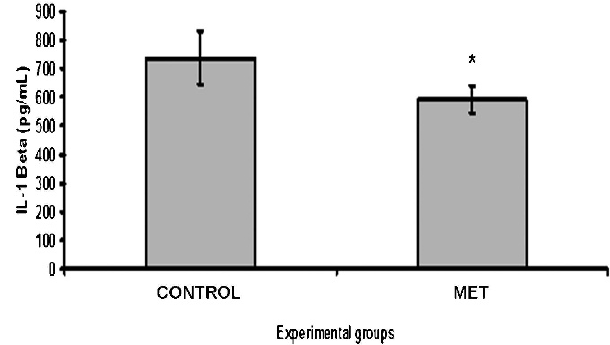
Figure 1 - Pulmonary tumor necrosis factor-alpha assay. After transplantation, there was a significant decrease in the levels of tumor necrosis factor-alpha in the methylprednisolone group compared with the control group (* p =0.0084). The values are expressed as the mean ¡ standard error of the mean.